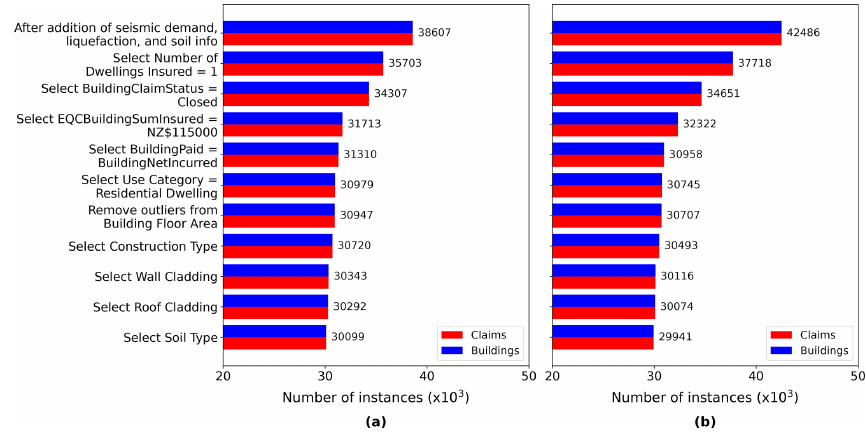
Figure 7. Evolution of the number of instances after each feature filtering step: (a) 4 September 2010 and (b) 22 February 2011.